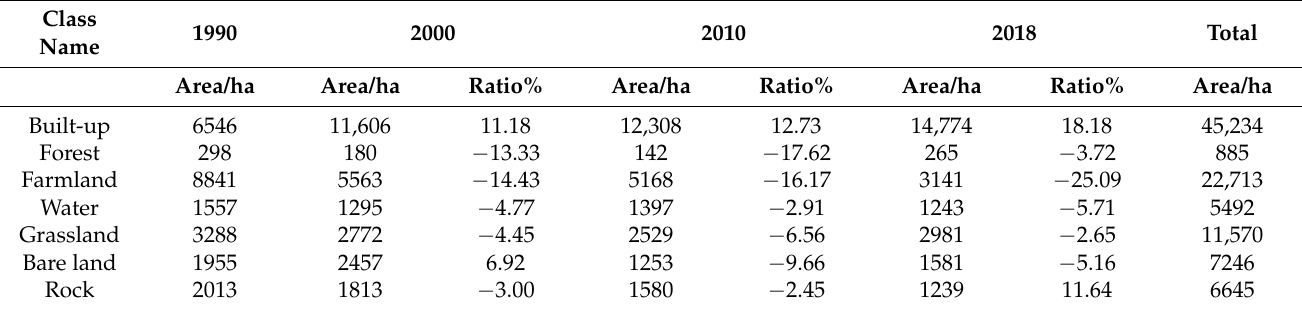
Table 7. Class areas and growth ratio (using 1990 as baseline) statistics per hectare from 1990 to